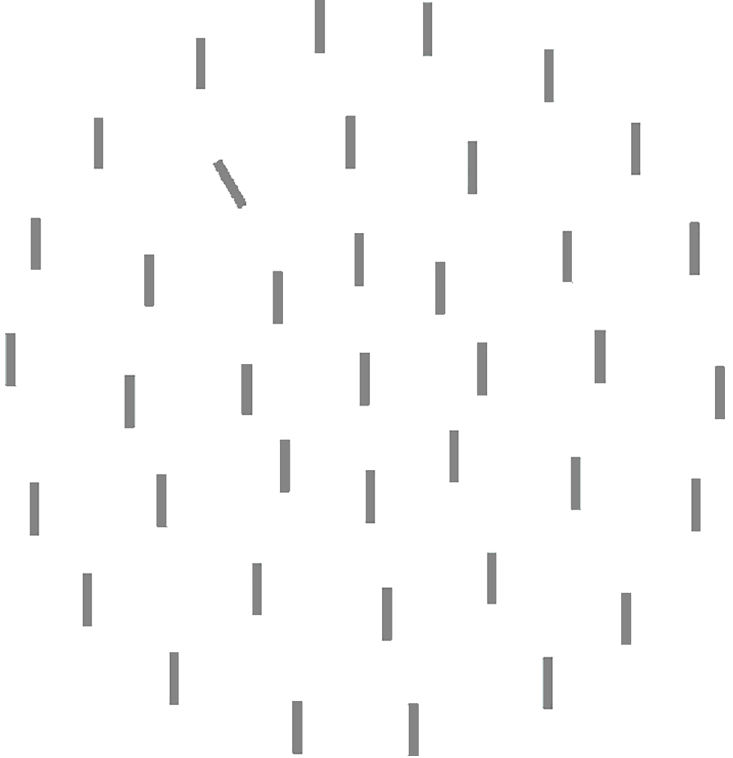
Fig 13. Example of visual search display with an orientation